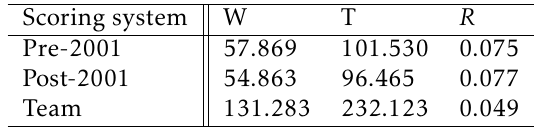
Table 4. Measures of game refinement for Table Tennis